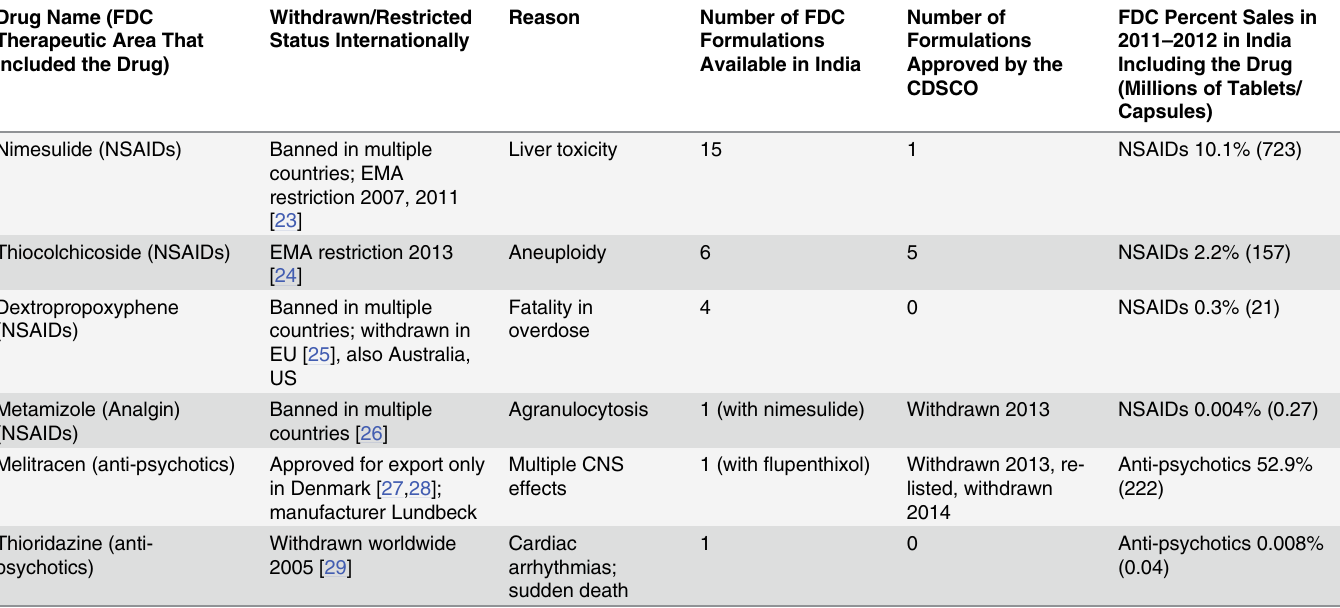
Table 5. Drugs withdrawn or restricted internationally that were included in FDC formulations marketed in India. Drug Name (FDC Therapeutic Area